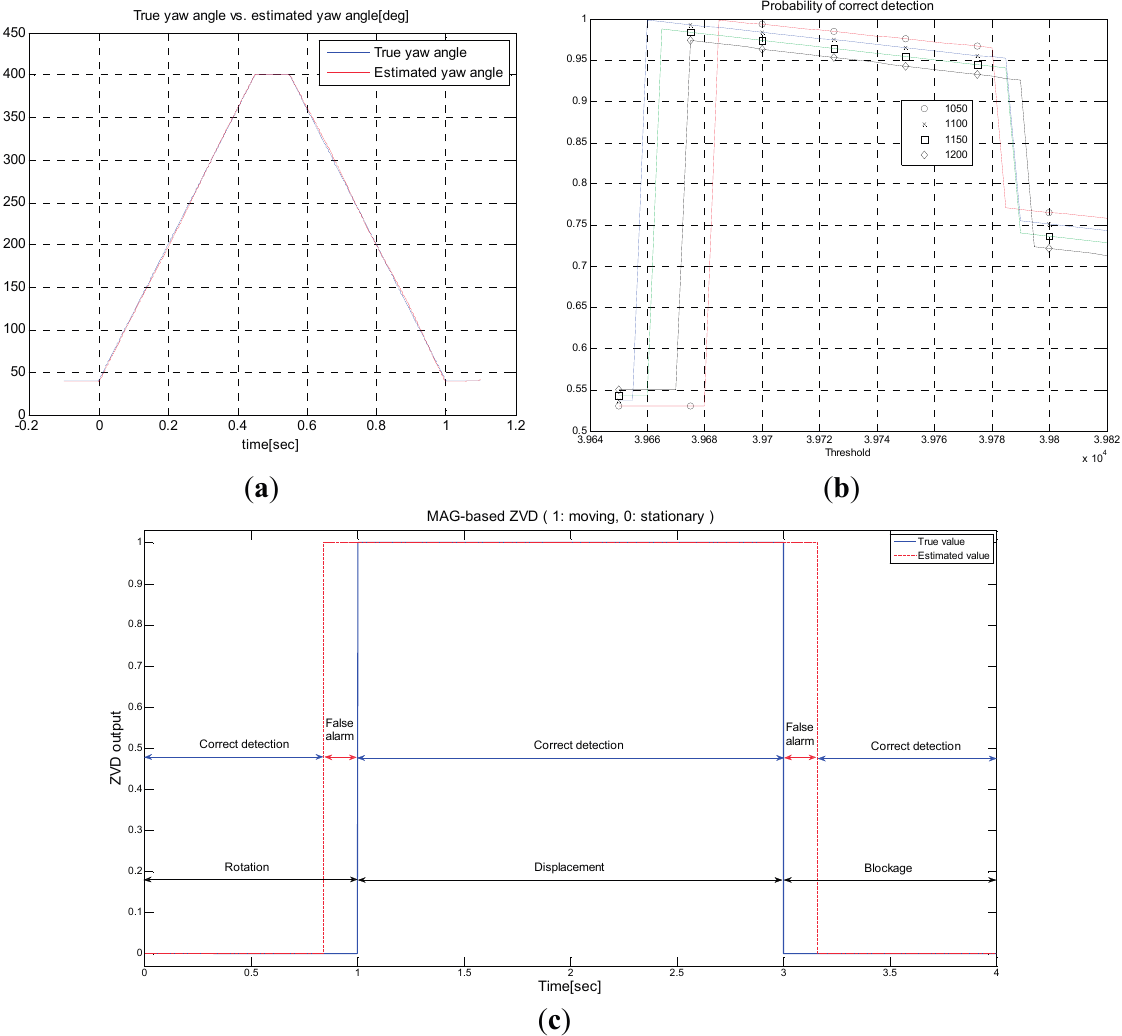
Figure 5. Performance of AHRS ( a ) Yaw angle estimated by AHRS in Scenario 1; ( b ) Probability of correct detection for the MAG-based ZVD ( c ) Performance of the MAG-based ZVD for three different